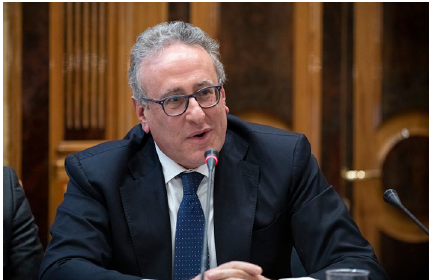
Fig. 10 Westerdijk Fungal Biodiversity Institute